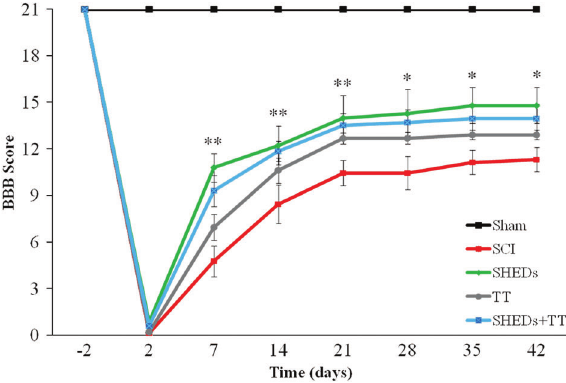
Figure 3. Progress of hind limbs functional recovery after incom- plete spinal cord injury (SCI), as evaluated with the BBB scale, in sham operated (Sham), SCI, SCI treated with stem cells from human exfoliated deciduous teeth (SHEDs), SCI treated with treadmill training (TT), and SCI treated with SHEDs and treadmill training (SHEDs + TT) rats. Data are reported as means ± SE. *Signi fi cantly different comparing the SHEDs group to the SCI group; **signi fi cantly different comparing the SHEDs and the SHEDs + TT groups to the SCI group. Statistical analysis was performed using repeated-measures ANOVA to detect treatment effects over time, and individual one-way ANOVA followed by Tukey ’ s post hoc were performed to observe intraday